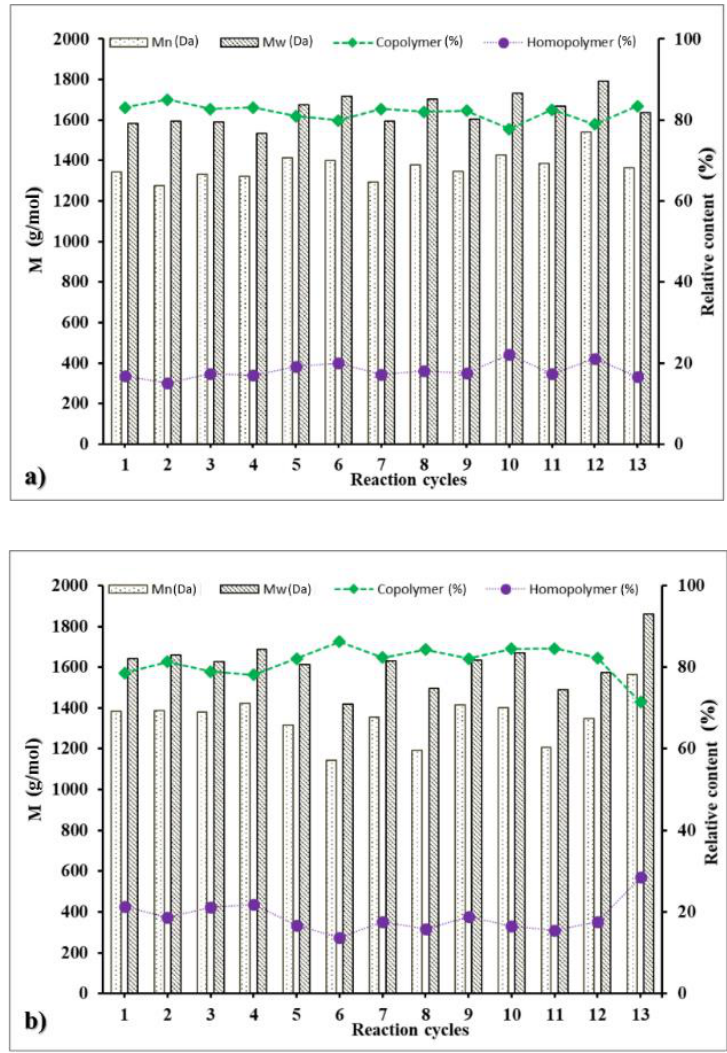
Figure 4. The operational stability of Novozyme 435 ( a ) and GF-CalB-IM ( b ) in repeated reaction cycles for the synthesis of oligoesters containing malic acid units. Reaction parameters: ECL:MA molar ratio 2:1 in a solventless system at 80 °C for a 24-h reaction time.